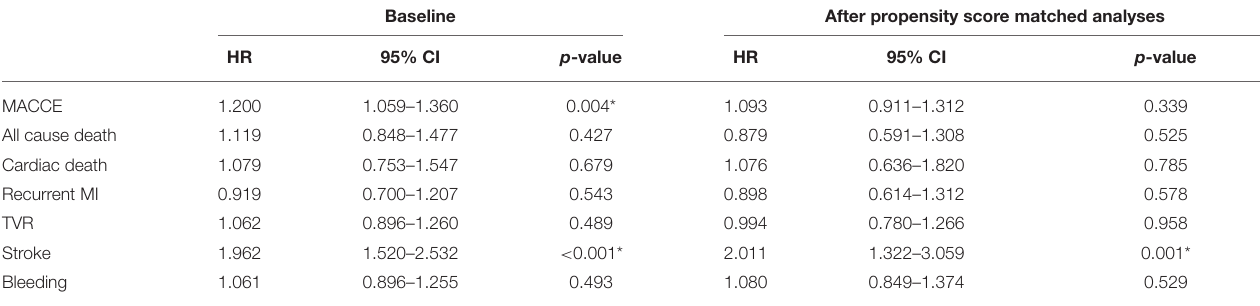
TABLE 3 | Multivariable regression analyses of prior stroke for 5-years long-term prognosis. Baseline After propensity score matched analyses 95% CI p -value